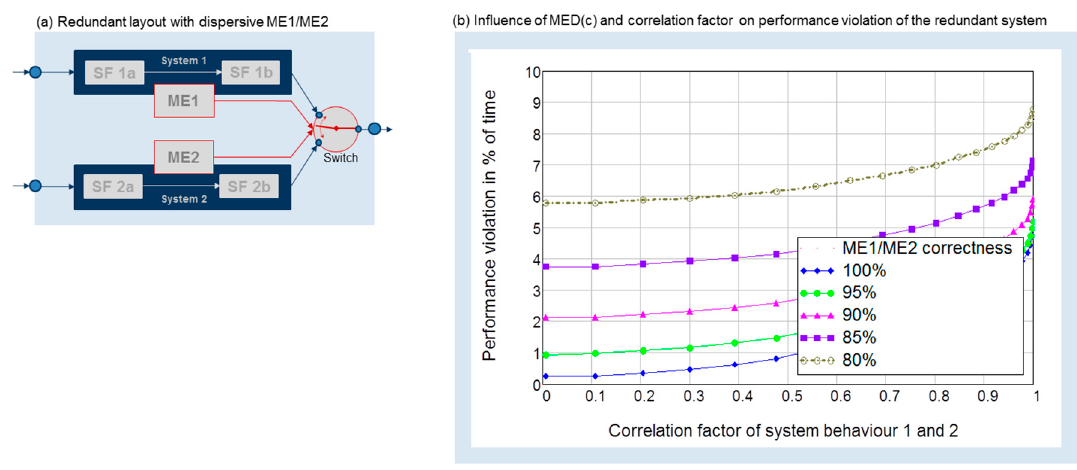
Figure 2. Redundant layouts of a system (consisting of two system functions SF a and SF b) with functional redundancy and dispersive monitoring and evaluation functions ( a ) and remaining performance violation ( b ) as a function of correlation factor between the branches and correctness of ME1 and ME2 functions (assuming a perfectly functioning of decision logic and switch).